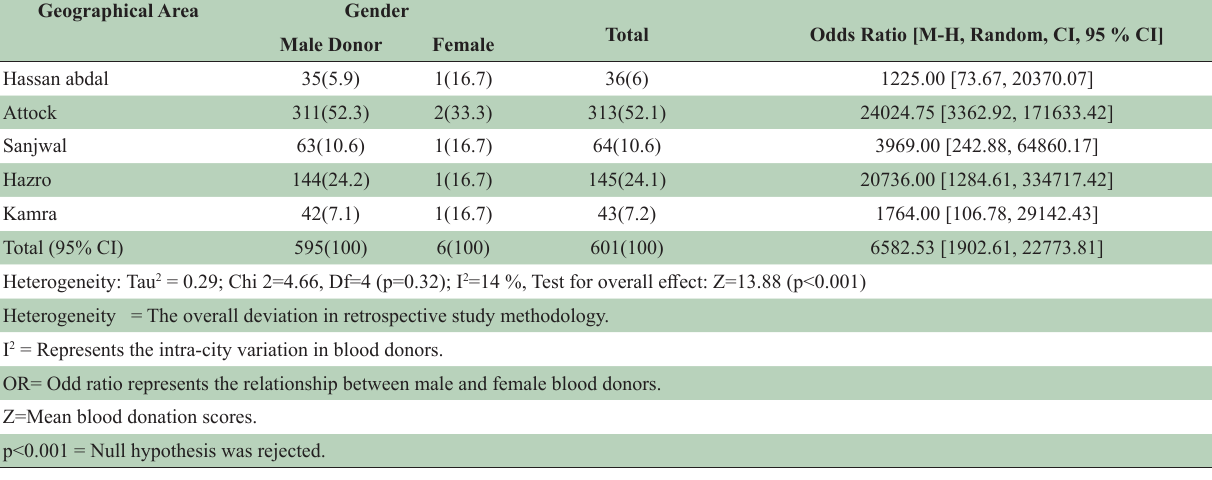
Table-III: Comparative Inter-city versus intra-city healthy blood donor’s assessment. Geographical Area